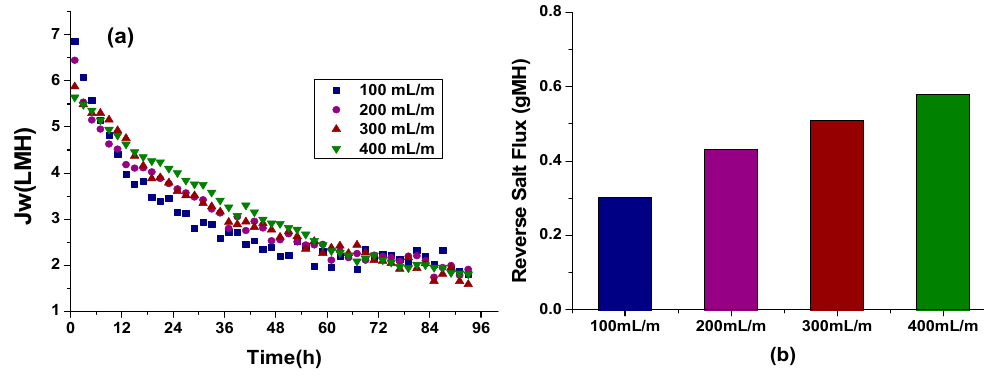
Figure 6. ( a ) Water flux of different DS flow rates in the MF ‐ FDFO ‐ MBR hybrid system; and ( b ) RSF of different DS flow rates in the MF ‐ FDFO ‐ MBR hybrid system (DS: SOA; Feed solution: Synthetic wastewater; DS concentration: 1 M; Temperature: 22 ± 0.5 °C).